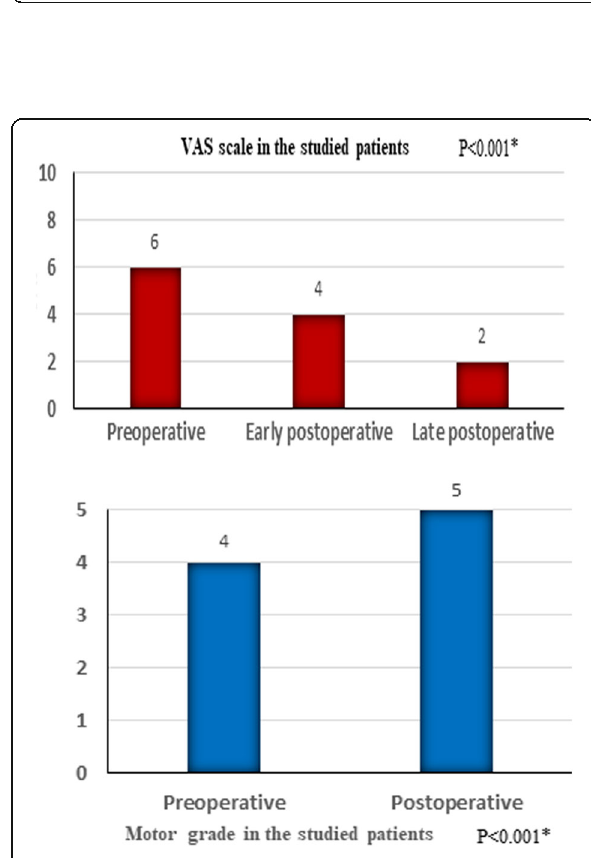
Fig. 3 a Operative view; arrow points to a disk fragment. b Axial T1 MRI superimposed on the operative photo showing ruptured PLL (arrow) and posterolateral herniated disk fragment. The asterisk refers to the extracted disc fragment leaving a defect in PLL. c Complete opening of PLL